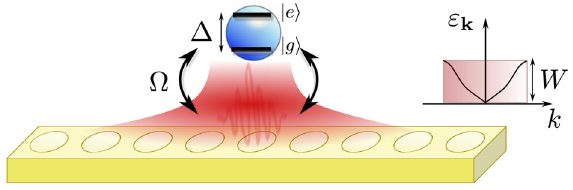
FIG. 1. Single impurity with energy Δ coupled through Ω to a bath with dispersion relation ε k and a bandwidth W . A bosonic bound state (in red) localizes around the